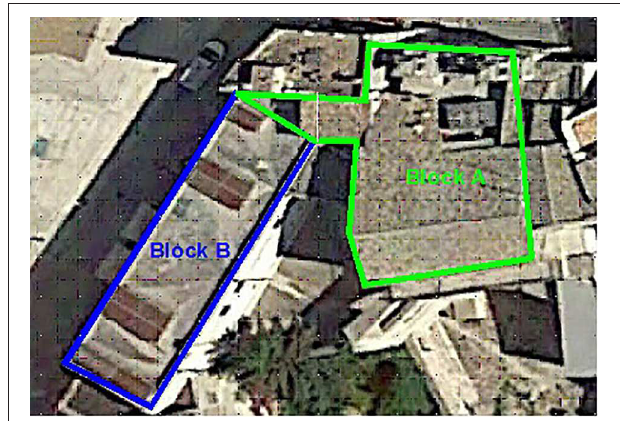
FIGURE 3 | Ortho image of “Sedile Building”.